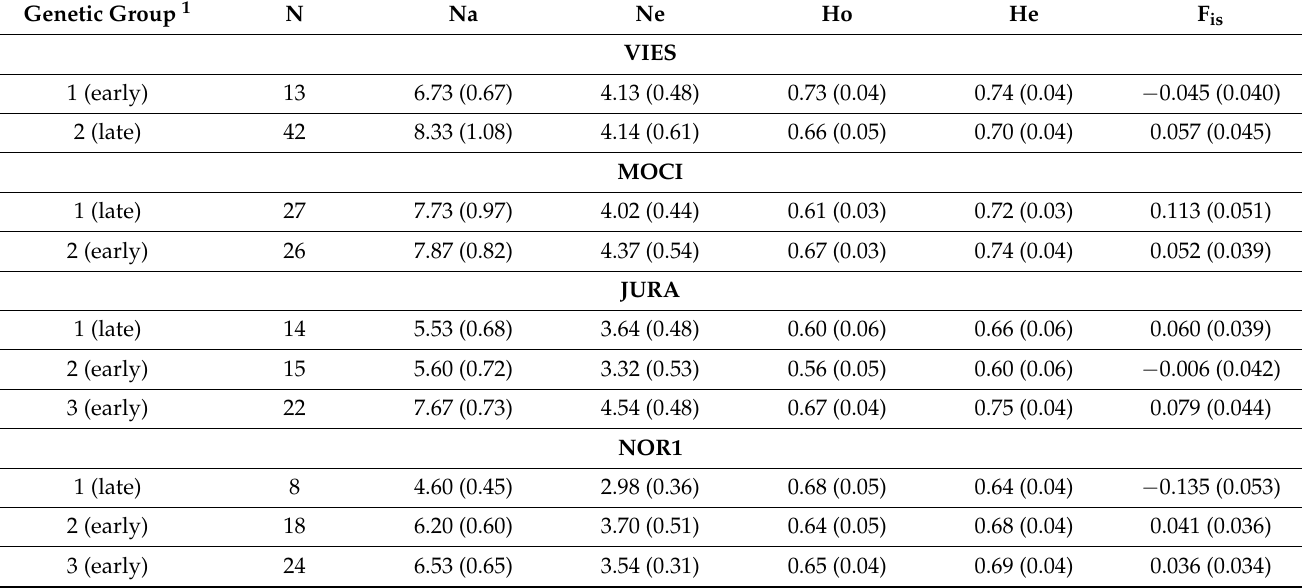
Table 5. Genetic diversity parameters compared between the STRUCTURE genetic groups in each of the studied stands (the multilocus standard errors on the brackets). N-group size. Na-mean number of different alleles, Ne-effective allele number, Ho and He observed and expected heterozygosity (adjusted for sample size), F is -inbreeding